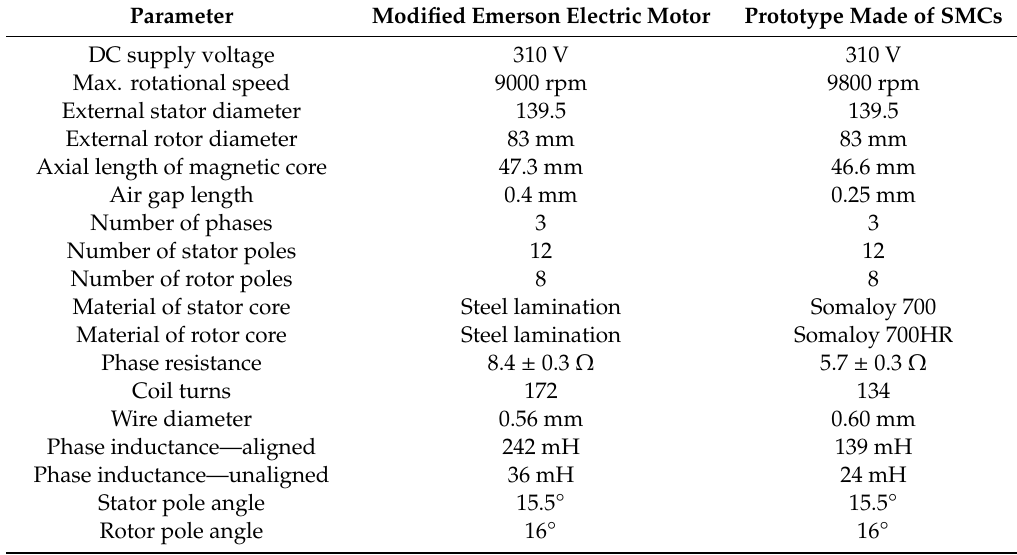
Table 1. Parameters of modified Emerson Electric motor and prototype made of soft magnetic composites